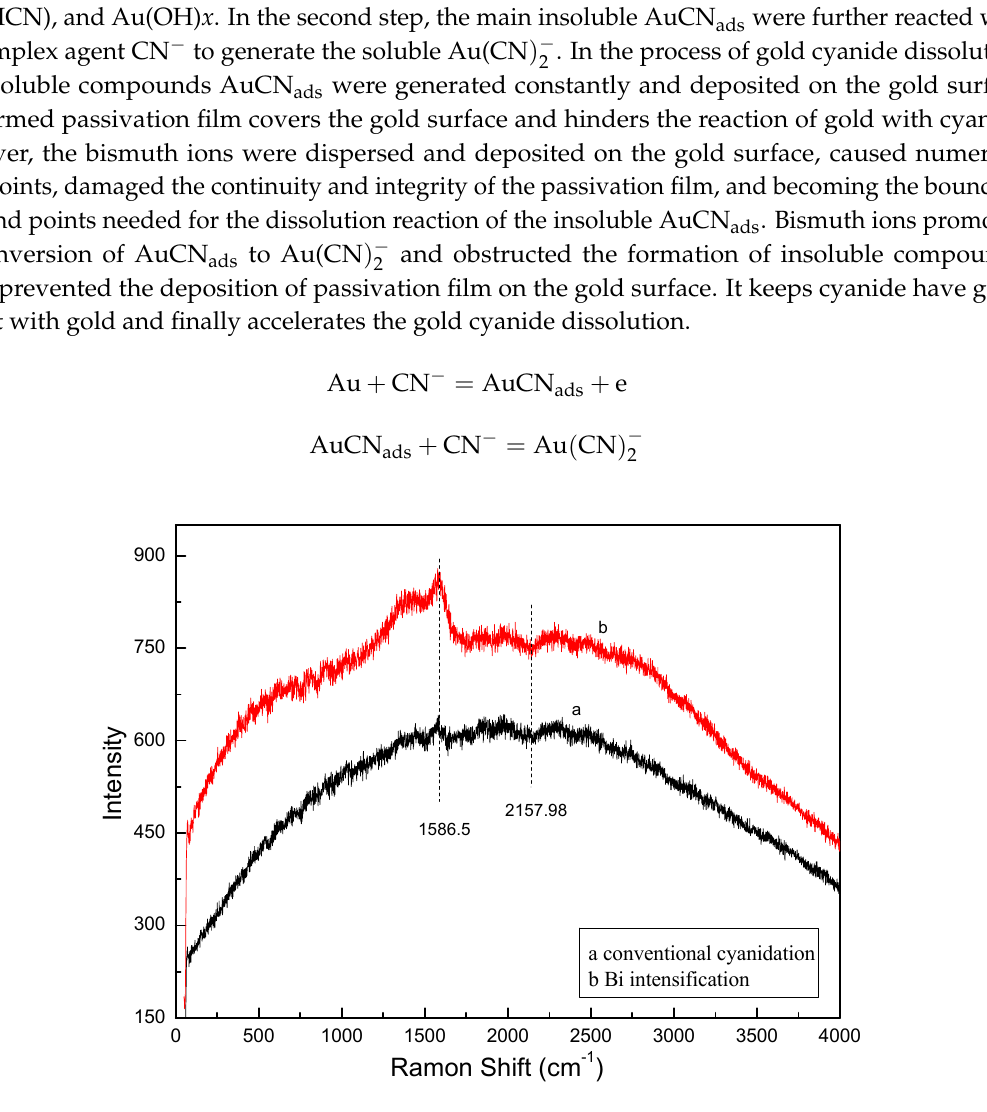
Figure 10. Raman spectra of gold plate under conventional and Bi intensification cyanidation.